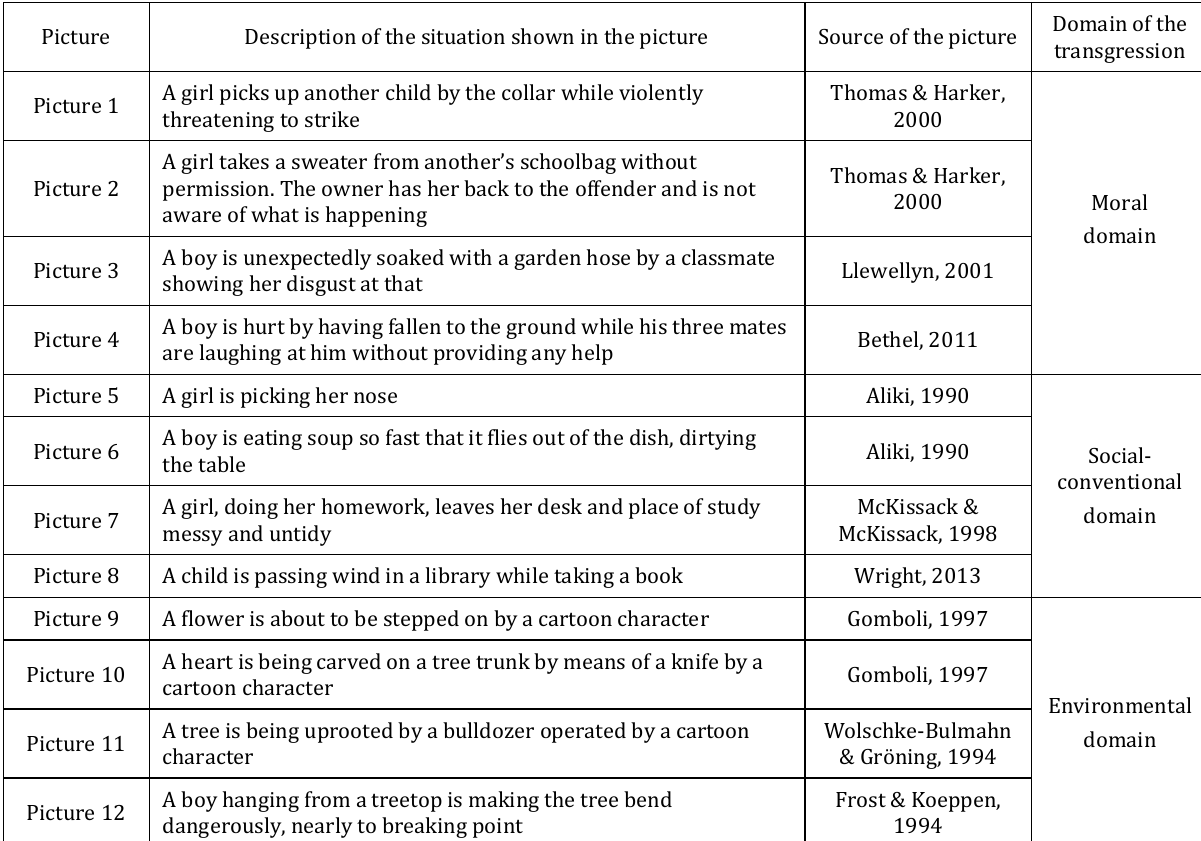
Table 2. Detailed information regarding the pictures used to conduct the Environmental Judgement Test